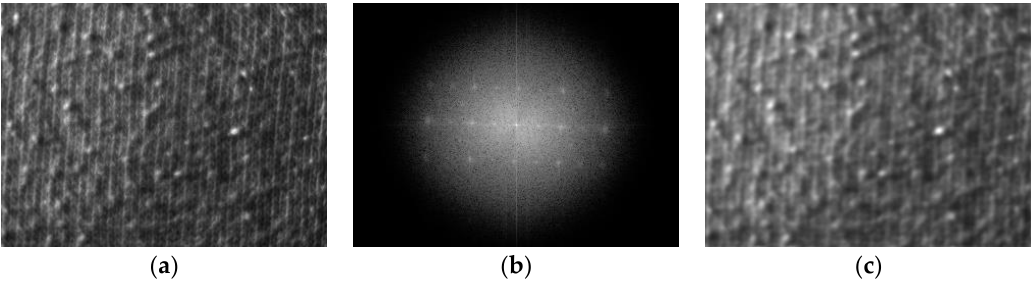
Figure 3. ( a ) Original image, ( b ) spectrum obtained through FFT using a Gaussian filter, and ( c ) inverse Fourier transform IFFT image.